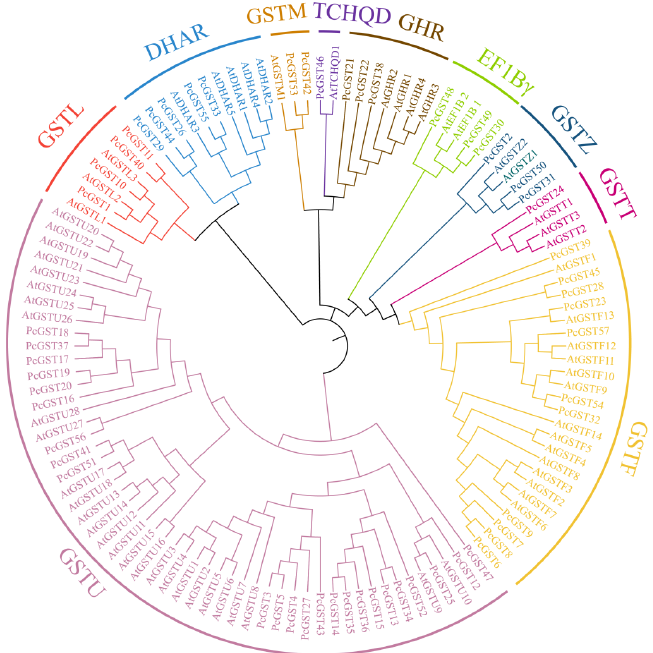
Figure 1. Phylogenetic analysis of GST genes from European pear and Arabidopsis . An unrooted phylogenetic tree was constructed using the full-length protein sequences of GST by MEGAX using neighbor-joining method, with 1000 bootstrap replicates. The branches with different colors indicates 10 subfamilies of GST